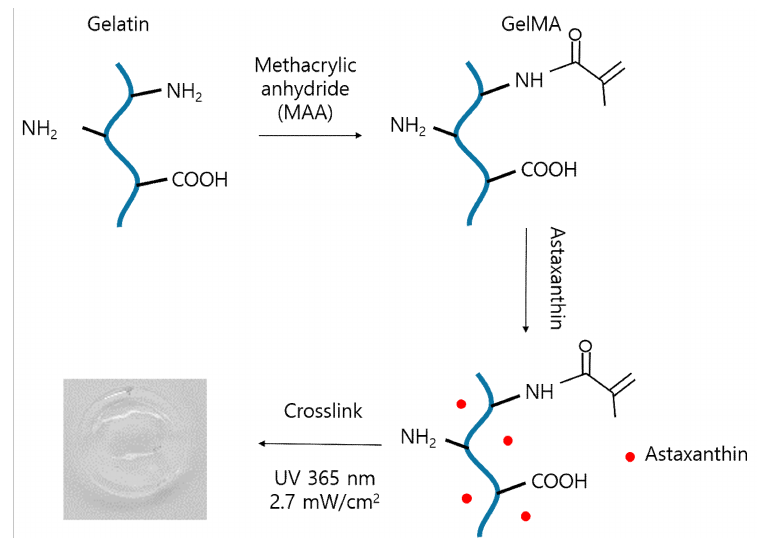
Figure 3. Schematic image of the fabrication of astaxanthin-incorporated gelatin methacryloyl (GelMA) scaffolds.